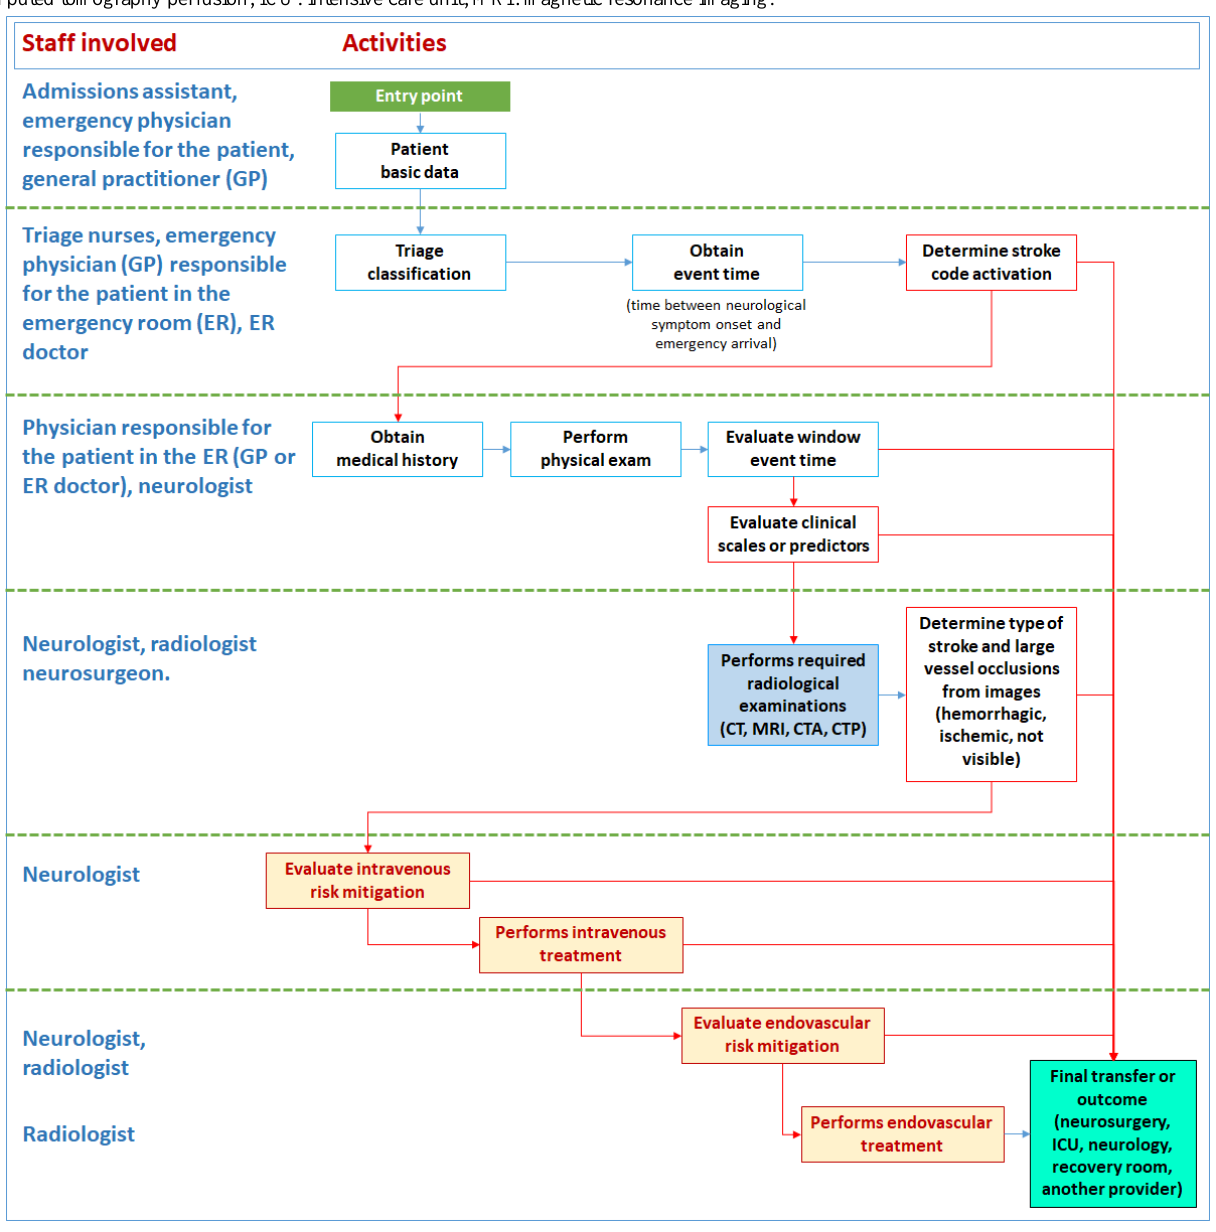
Figure 2. General simplified workflow for the three health care settings. CT: computed tomography; CTA: computed tomography angiography; CTP: computed tomography perfusion; ICU: intensive care unit; MRI: magnetic resonance